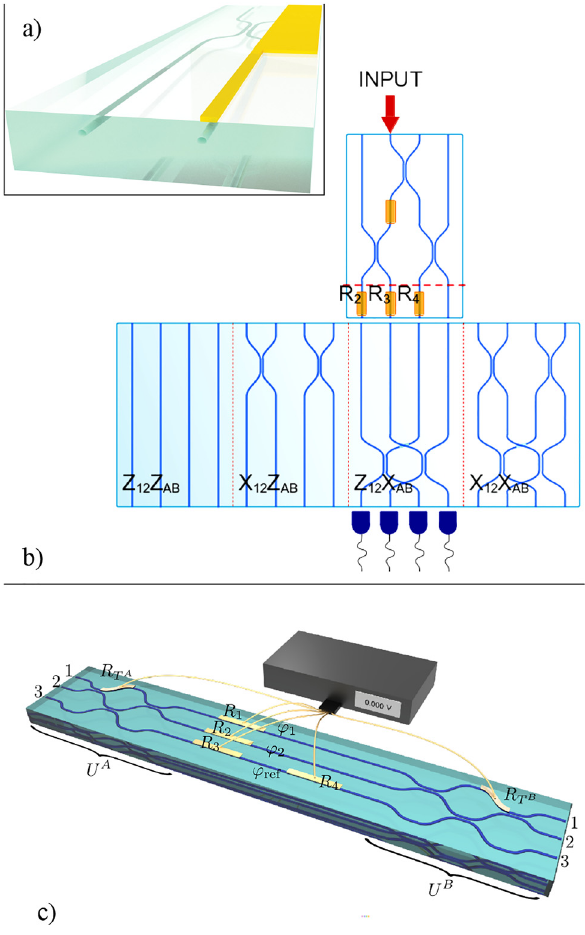
Figure 5: (a) 3D section of a reconfigurable Mach–Zehnder interferometer:a metallic heater is patterned on top of one of the interferometer’s arms. (b) Pictorial scheme of the two cascaded photonic chips employed in Ref. [ 156 ]. The first one encode a two-qubit path-encoded state of a single photon. The second chip, in conjunction with the four single-photon detectors at the output, enables to perform different measurements on the two-qubit